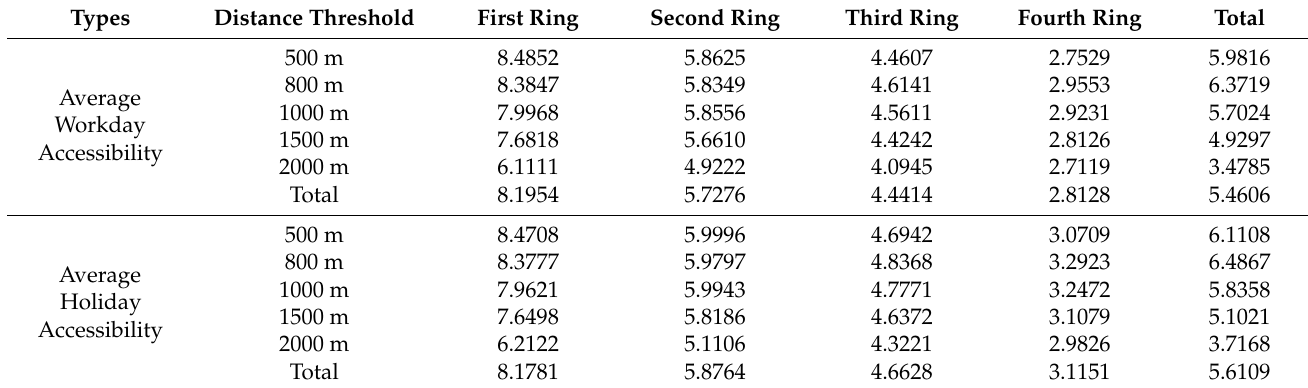
Table 3. Average accessibility of metrorail in various service areas and rings.